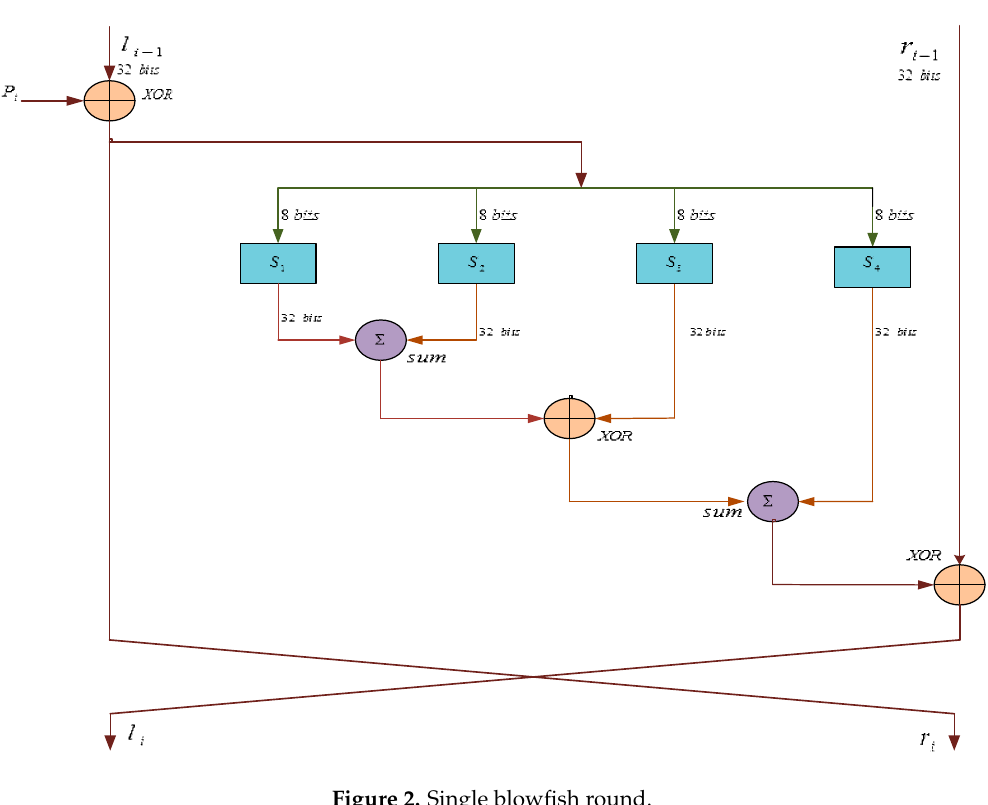
Figure 2. Single blowfish round.